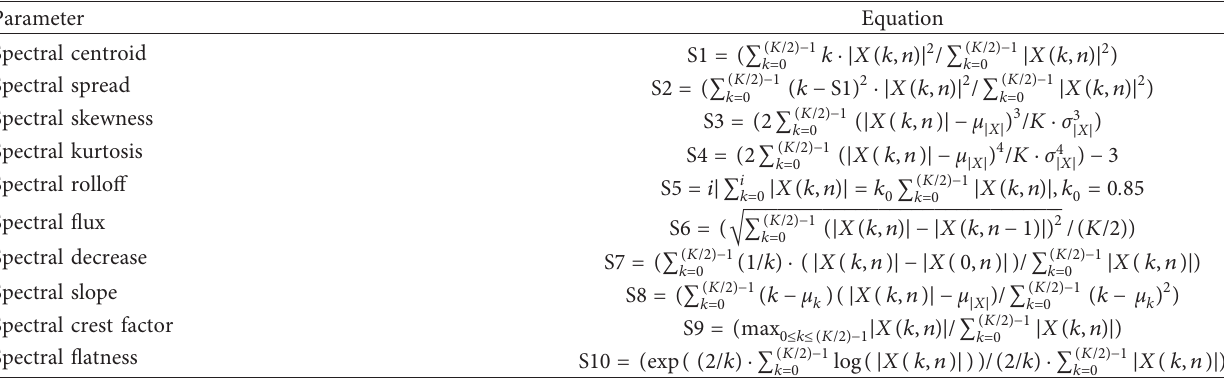
Table 1: Features from time-frequency